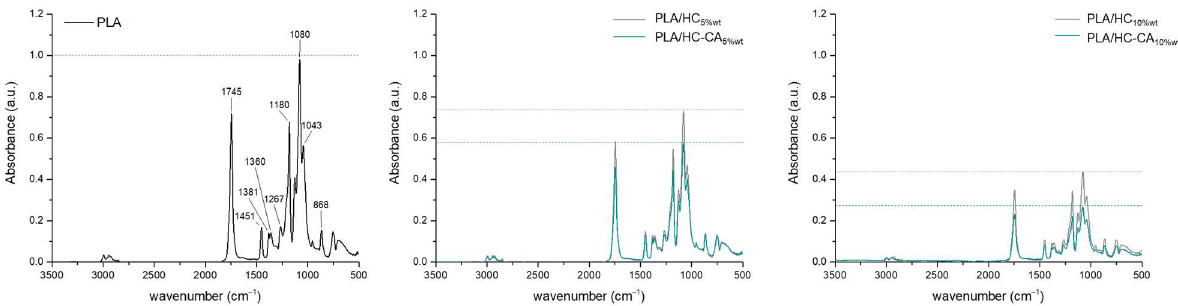
Figure 9. ATR-FTIR spectra of PLA and PLA-based biocomposite films. Spectra were processed using OriginPro 2015 software.